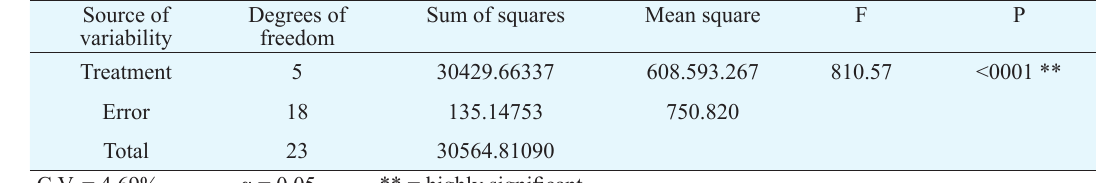
Table 8. Results of the analysis of variance for the in vitro evaluation of fungicides against Corynespora cassiicola .